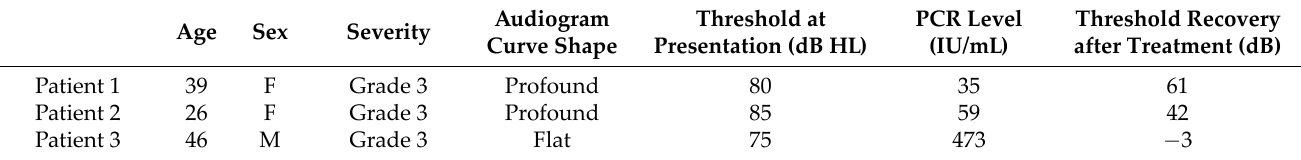
Table 3. Features of patients with positive